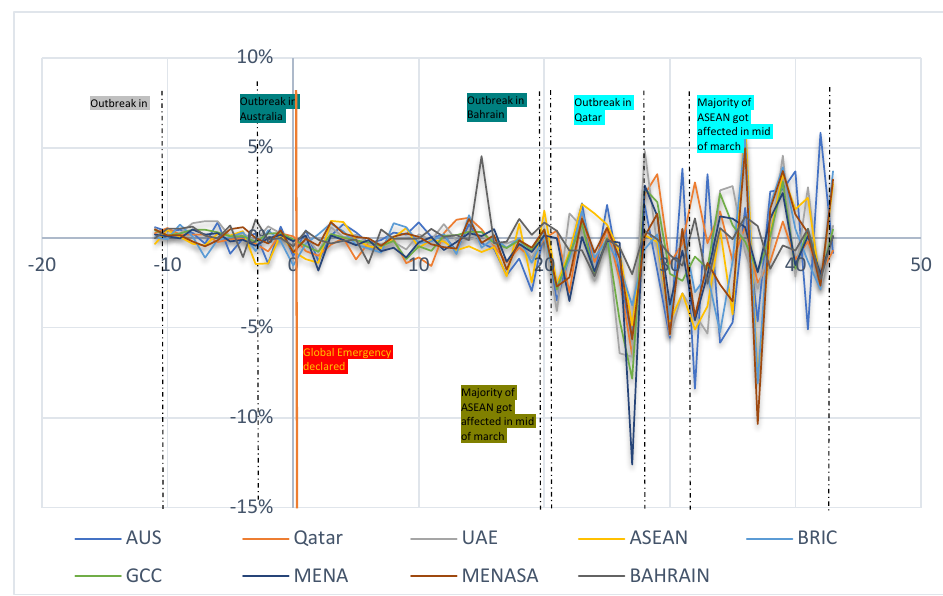
Figure 1. Abnormal return (AR) change of Thomson Reuters Islamic stock indices. Figure 2 represents the cumulative abnormal returns (CAR) of all selected Thomson Reuters Islamic indices. We could draw the conclusion that in most countries or regions the outbreak of the pandemic had occurred after mid-February or the beginning of March 2020. However, the markets responded accordingly soon after the first confirmed COVID- 19 case appeared. Furthermore, Islamic stock indices from MENA, MENASA, and BRIC produced negative returns after the short-term window. The outbreak in the region of MENA, MENASA, and BRIC happened as early as 31 December 2019 in China and as late as 1 April in Yemen. As a result, news related to COVID-19 directly affected the investor’s sentiments and hence the market reaction.